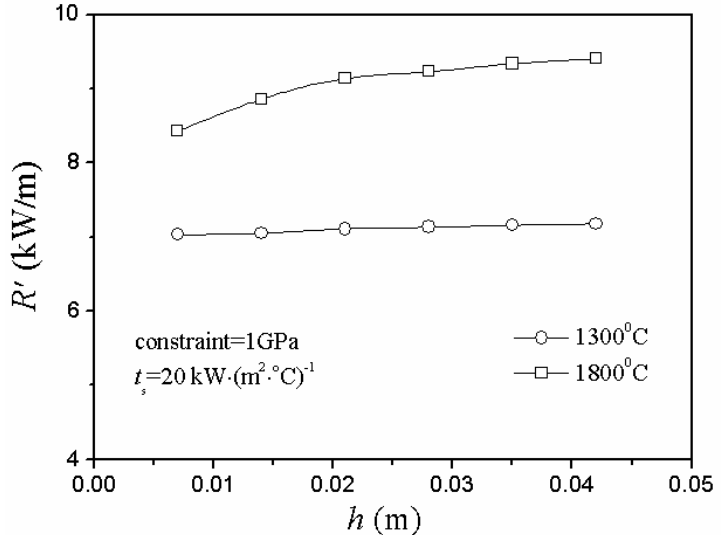
Figure 6. Relationship between the second thermal shock resistance (TSR) parameter, R’ , and plate thickness, h , under different initial thermal shock temperature of cooling